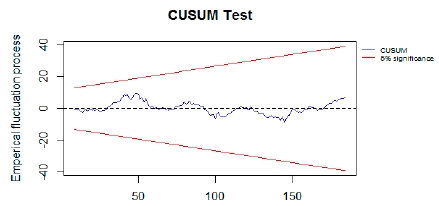
Figure 8. CUSUM test of Trappista cheese.